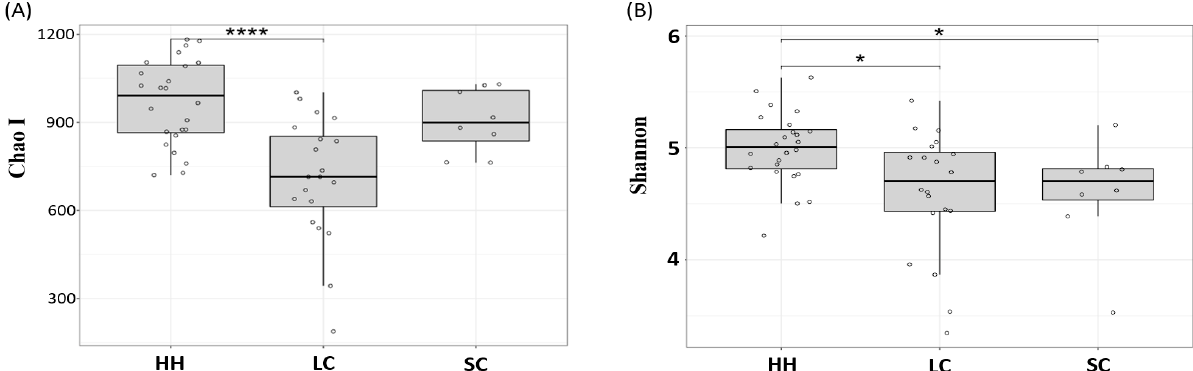
Figure 1. Comparison of the horse fecal microbiota ecological indices for species richness using Chao I ( A ) and species evenness using Shannon ( B ). Significant mean difference evaluated by Wilcoxon test are indicated with * and **** for p < 0.05 and p < 0.0001, respectively. HH, healthy horses; LC, horses with large intestinal colic; SC, horses with small intestinal colic.